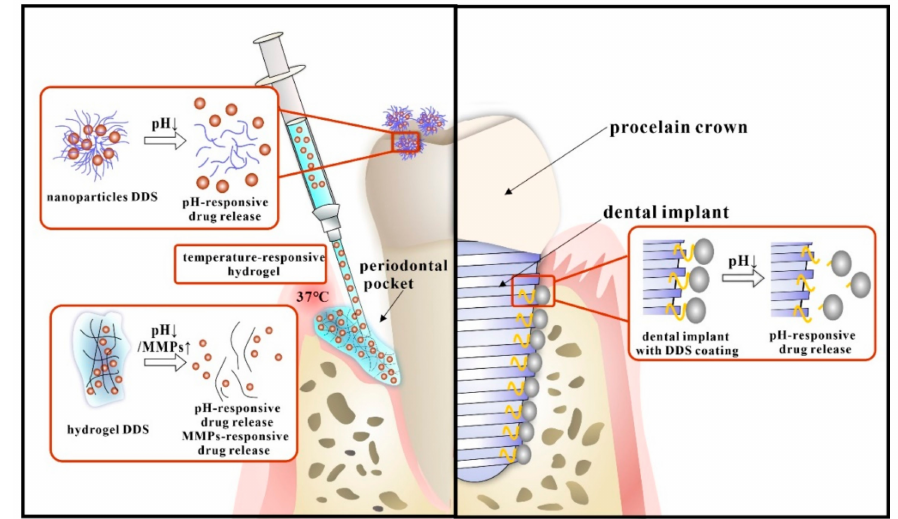
Figure 7. Recent stimuli-responsive DDS in oral infectious